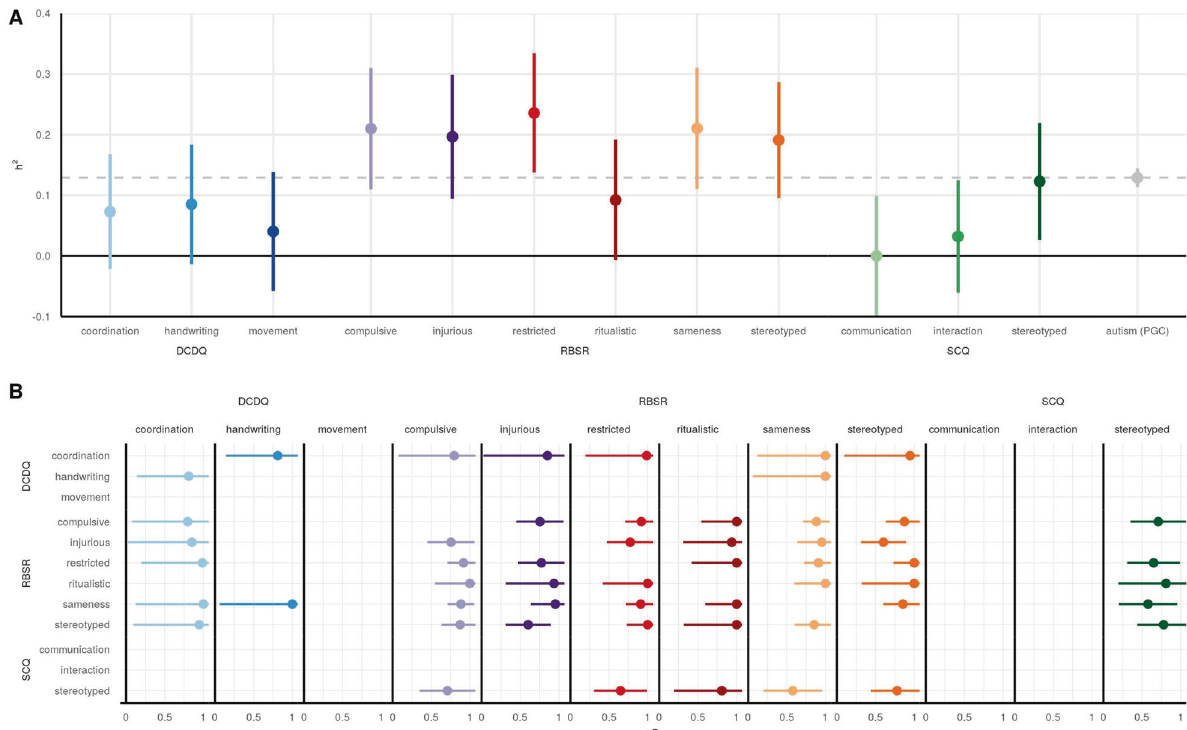
Fig. 3 SNP heritabilities and genetic correlations. A SNP heritabilities ( h 2 ). The mean h 2 estimate is plotted with the whiskers representing the 95% con fi dence intervals. For comparison, the autism case-control (PGC) heritability is also shown. B Intra-cohort genetic correlations (rG). The mean rG estimate is plotted with the whiskers representing the 95% con fi dence intervals. The rG value is plotted only if the correlation is nominally signi fi cant (unadjusted p -value < ( h 2 ) for each subscale, which is the proportion of variance in the phenotype (subscale) that can be explained by the variance in the measured genetic data (the SNPs). We calculated the heritabilities